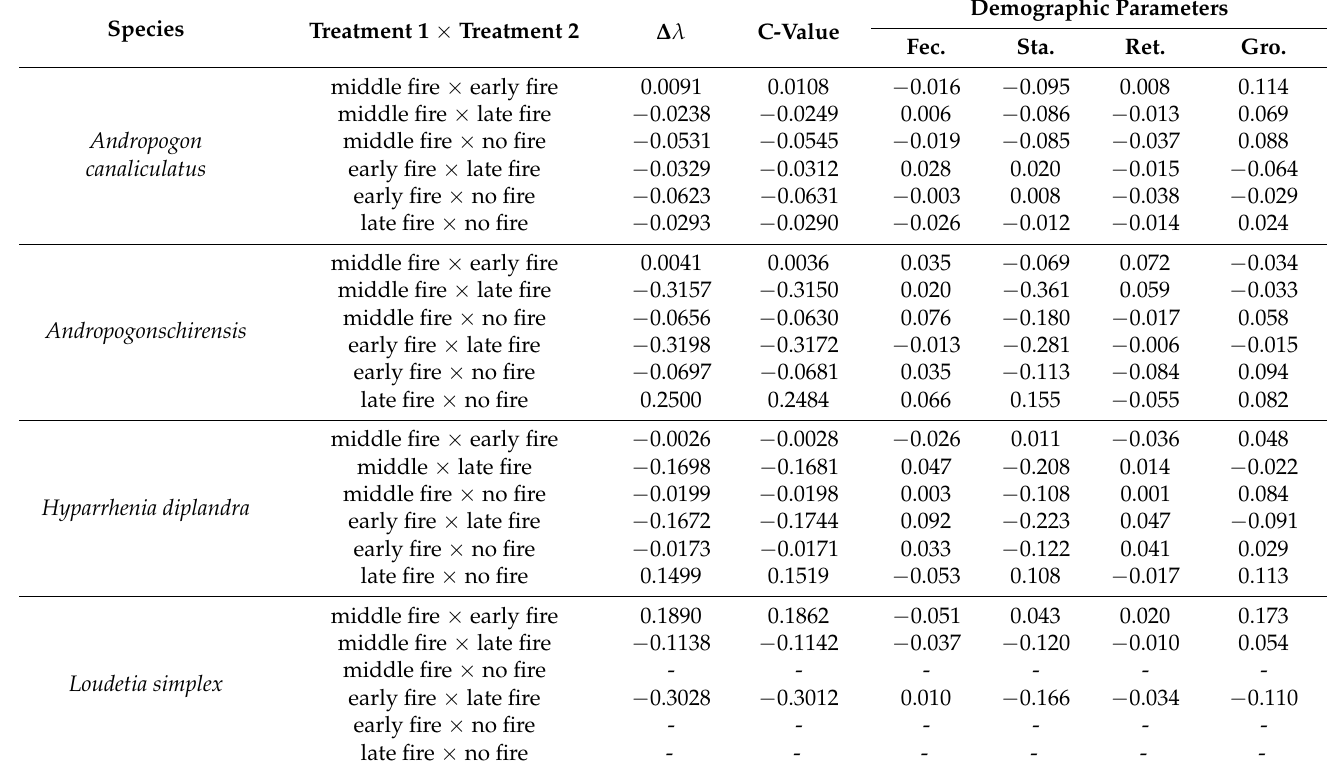
Table 5. Contribution of the grouped demographic parameters (Fec.: fecundity, Sta.: stasis, Ret.: retrogression and Gro.: growth) to the demographic difference between treatments in each species, analysed by the life-table response experiment. When the demographic parameters are higher in treatment 2 than in treatment 1, contribution values are positive and vice versa. Treatment 1: the first of the two compared fire treatments; treatment 2: the second treatment; ∆ λ = λ (treatment 2) − λ (treatment 1) : the difference between the asymptotic growth rates ( λ ) of treatment 1 and treatment 2; C-value: the global contribution value calculated by summing all the entries of the contribution matrix from the comparison between the corresponding treatment. The (-) denote that there was no possible comparison between the other treatments and no fire in Loudetia simplex .